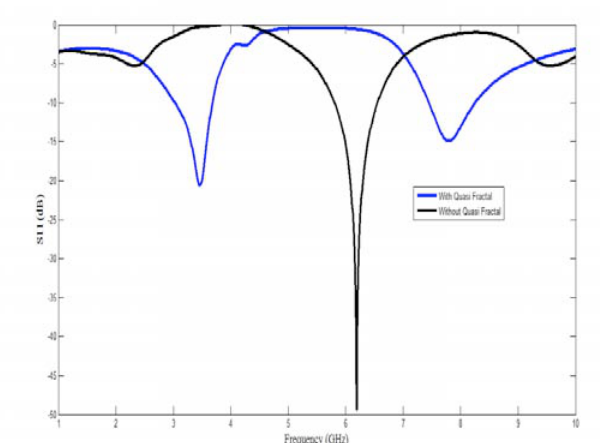
Figure 6 S11 responses with and without quasi-fractal approach for antenna design